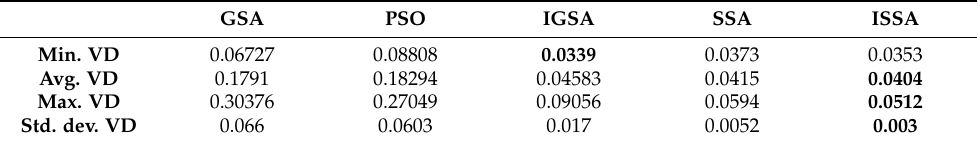
Table 7. Statistical comparison of results for voltage deviation minimization for IEEE 14-bus